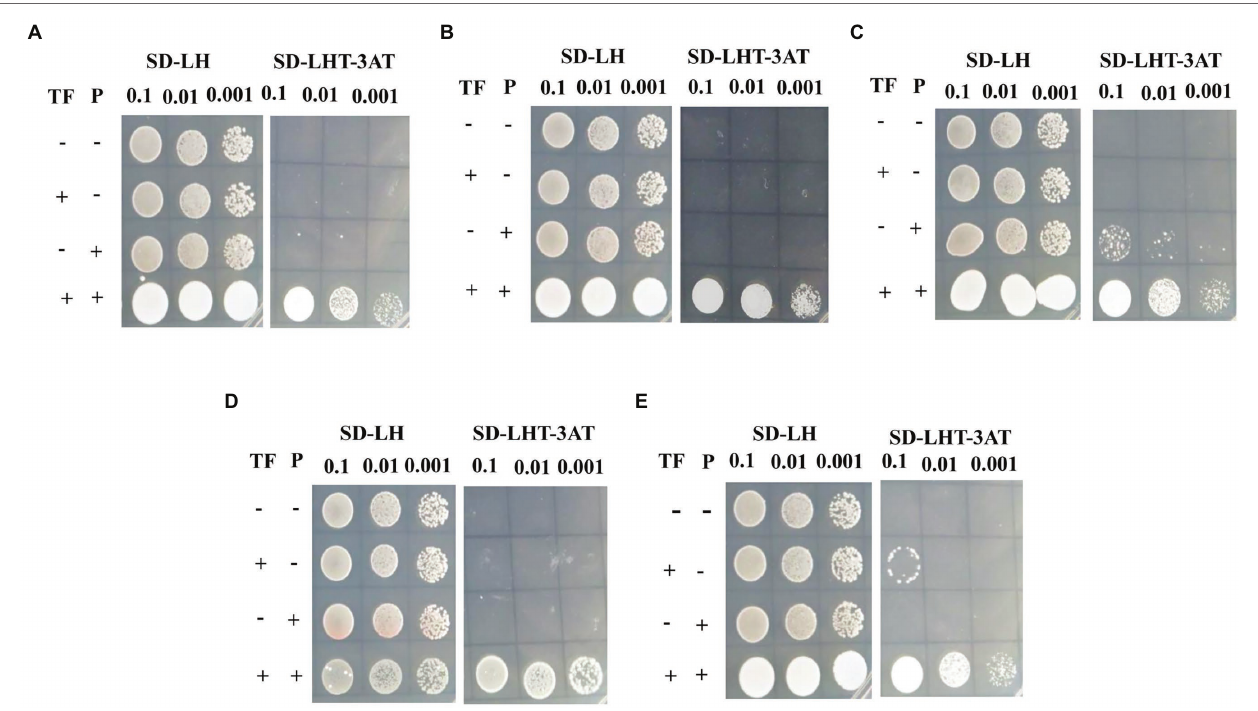
FIGURE 6 | Assessment of VpxlnR binding activity using yeast one-hybrid (Y1H). Genes were selected from PHI-BLAST analysis, including (A) VP1G_09520: salicylate hydroxylase, (B) VP1G_03128: serine/threonine-protein kinase, (C) VP1G_06369: alpha-xylosidase, (D) VP1G_02856: G-protein beta subunit, and (E) . VP1G_03782: acid phosphatase. VpxlnR and pHis2::P coexpressed in yeast cells were cultured on SD/ − Leu/His plates, and positive clones were screened on SD/ − Trp/ − Leu/-His plates with 3AT plates. TF: VpxlnR, P: promoter. Empty pGADT7 ( − ) and empty pHIS2 ( − ) plasmids, and pGADT7:: VpxlnR / empty pHIS2 vector and empty pGADT7/pHIS2::P were used as controls. (+) indicates that the yeast cells expressed VpxlnR or contained gene promoters. The liquid